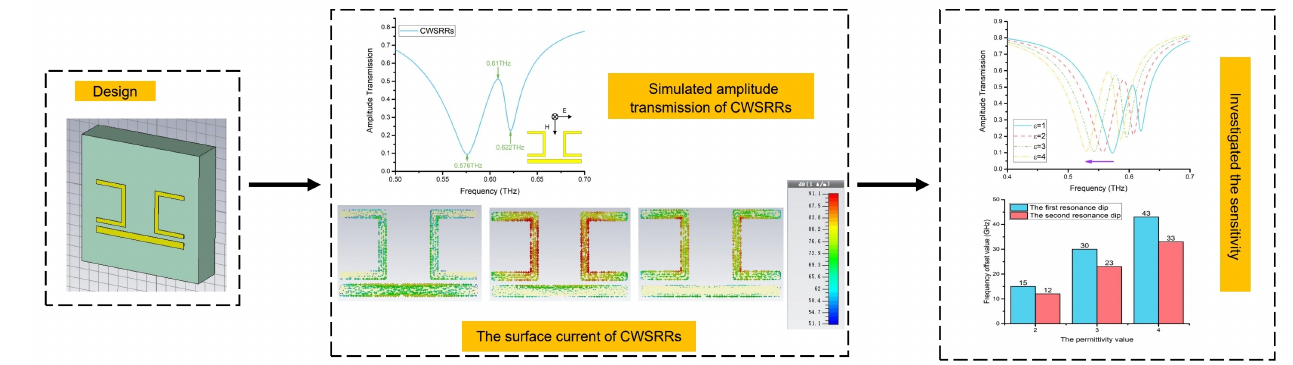
Figure 3. The flow chart for the simulation